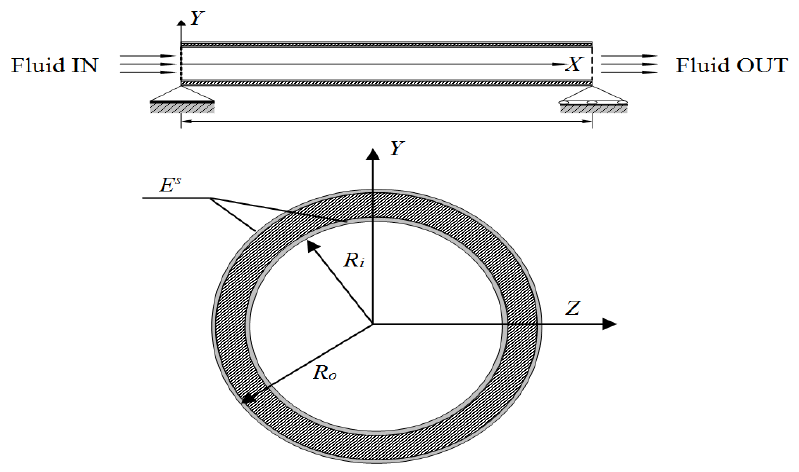
Figure 1. Schematic diagram of a nanotube conveying fluid.